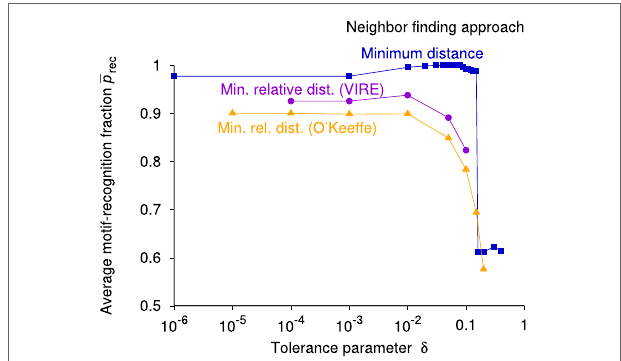
FIGURE 7 | Average fractions of sites for which the expected motif types are correctly predicted, ¯ p rec , as functions of the tolerance parameter, δ , involved in the respective neighbor-finding method. Three different neighbor-finding methods are tested: minimum distance (blue squares), minimum relative distance using a valence-ionic radius estimator (VIRE; purple circles) as implemented in pymatgen (Ong et al., 2013), and minimum relative distance using the bond-valence parameters according to O’Keeffe and Brese (1991), orange triangles.